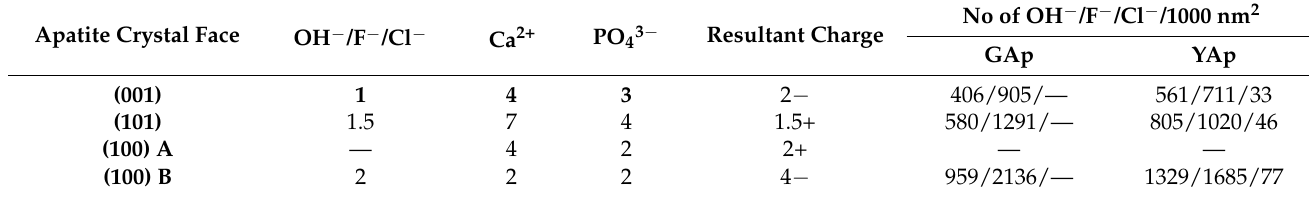
Table 3. Evaluation of ions/groups number per unit cell on the outermost layer for the following apatite crystal faces: {100}, {001} and {101}, and the approximate number of hydroxyls, fluoride, and chloride anions per surface area of 1000 nm 2 for GAp and YAp. Faces (100) A and (100) B corresponds to the ‘PO 4 -rich’ (Ca/P = 1.5 < 1.67) and ‘Ca-rich’ (Ca/P = 2.0 > 1.67) cases, respectively